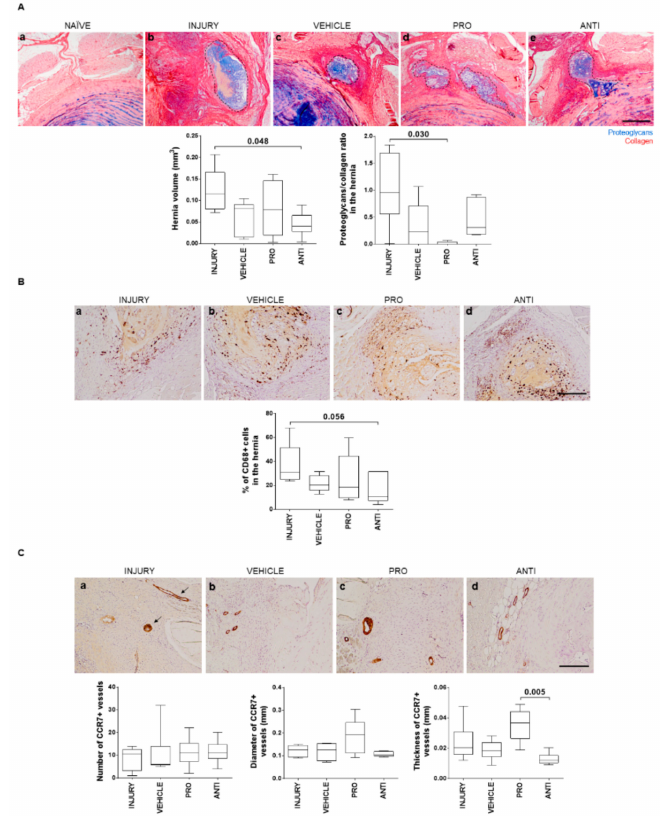
Figure 4. Histopathological analysis of herniation regions in lesioned IVDs 2 weeks post-injury and intradiscal administrations. ( A ) Representative images of the hernia formed in the di ff erent animal groups by Alcian blue / Picrosirius red staining (hernia delimited by dashed line; scale bar, 500 µ m); hernia volume (mm 3 ) was calculated from the staining across the depth of all sections of an IVD with visible herniation. ( B ) Macrophages identification within the hernia by CD68 immunostaining (positive cells are stained in brown). Representative images for all groups and respective CD68 + quantification within the hernia (scale bar, 200 µ m). ( C ) Blood vessels immunoreactivity to CCR7. Representative image of CCR7 + immunostaining for all groups. Blood vessels are stained in brown (arrows; scale bar, 200 µ m). Quantification of number, diameter (mm) and thickness (mm) of vessels. Results are presented in box-and-whiskers plots with associated p -value ( n = 6 animals / group). 2.4. Comparison of Intradiscal Pro- / Anti-Inflammatory Treatments in Systemic Immune Response At a systemic level, immune cell populations were analyzed in blood (BL), draining lymph nodes (LN) and spleen (SP) of the di ff erent animal groups (Figure 5A). The ANTI group showed a significant increase compared to VEHICLE-injected animals in the percentage of myeloid cells (CD11b + TCR-),